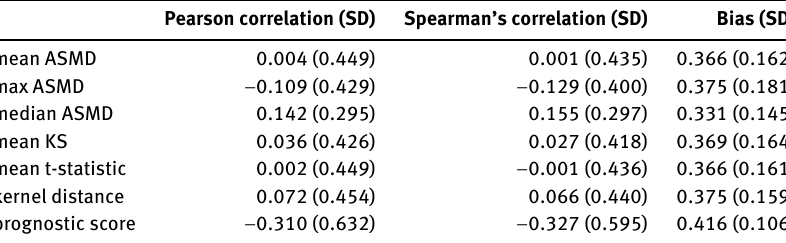
Table 5: Performance for Outcome Model E in Which Prognostic Score